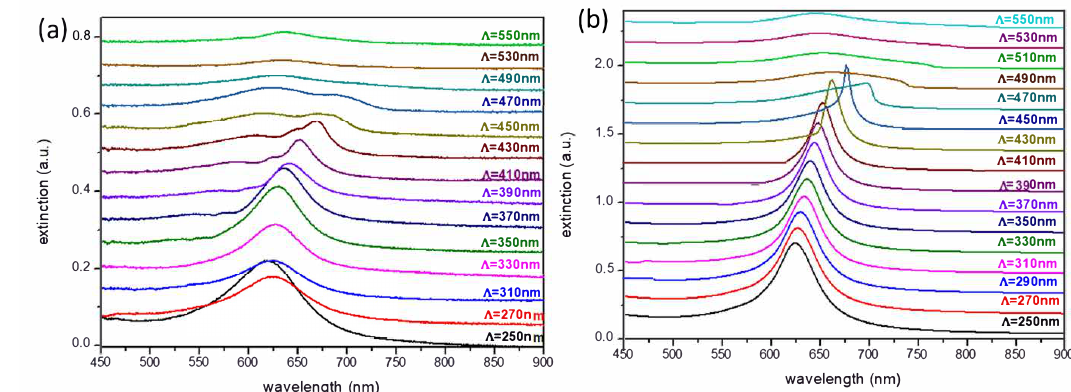
Figure 2. ( a ) Experimental and ( b ) calculated extinction spectra in air (in transmission, light at normal incidence and polarized along the x-axis) for square arrays of gold nanodiscs with a diameter D = 100 nm. The grating constant is varying from Λ = 250 to 550 nm with steps of 20 nm. The height of nanodiscs is fixed to h = 50 nm. The calculations have been obtained by the FDTD